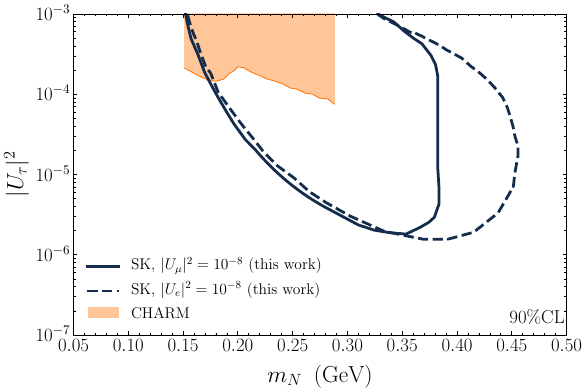
Fig. 4 SK constraints on the minimal HNL scenario at 90% CL, pro- jectedontotheplane | U τ | 2 vs m N ,for | U e | 2 = 10 − 8 and | U μ | 2 = 10 − 8 . Our results (black lines) are compared to the limits from CHARM [51] (which however have been obtained under the assumption | U e | 2 = | U μ | 2 =